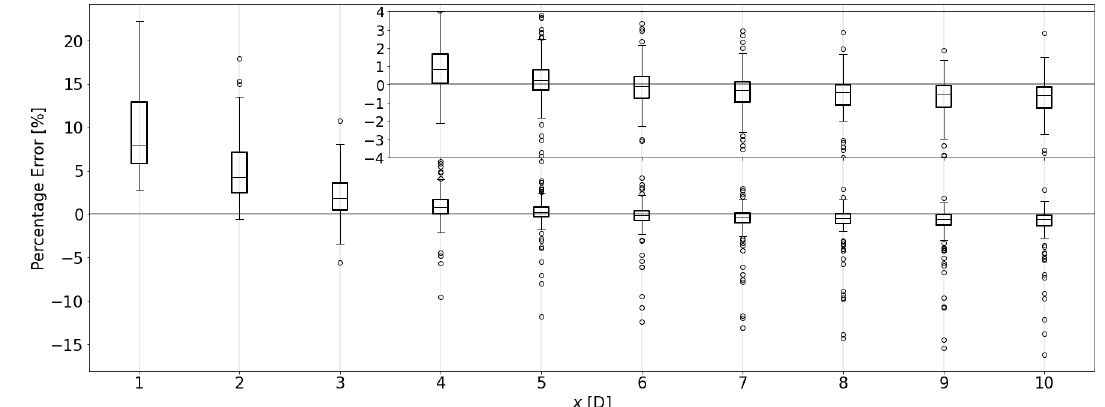
Figure 6. Accuracy of the wake composition procedure expressed as a percentage error in available power of a virtual downstream turbine. At each downstream distance, data from all 120 simulations are considered. The subplot in the top right zooms in to 4D ≤ x ≤ 10D. Axis labels correspond to those of the main